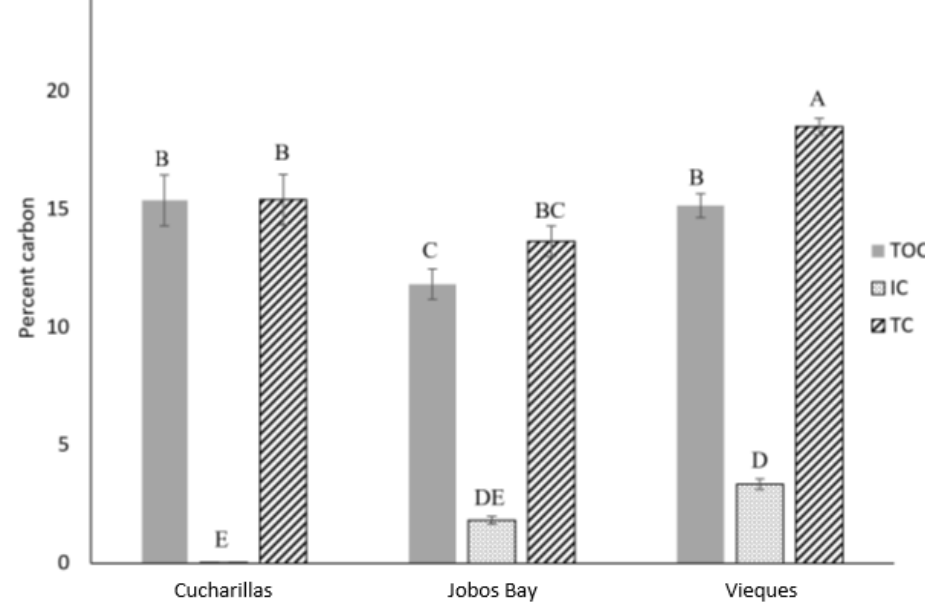
Figure 3. Average percent total organic carbon (TOC, shaded), inorganic carbon (IC, dotted), and total carbon (TC, striped) in the top 30 cm of soil at each location – Cucharillas, Jobos Bay, and Vieques. Error bars represent ± standard error. Similarity letters represent the results of Tukey HSD test.